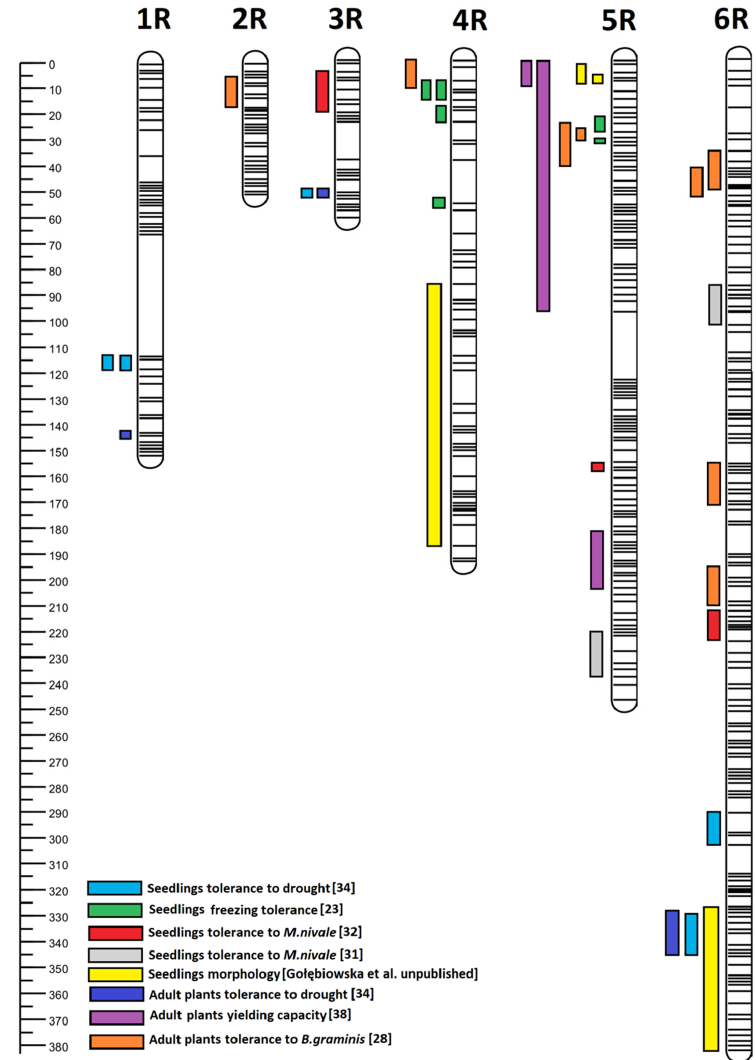
Figure 3. Subgenome R identified for the winter triticale DH ‘Hewo’ × ‘Magnat’ mapping population, related to seedlings the tolerance to drought, freezing, and pink snow mold caused by M. nivale as well as the tolerance of adult plants to drought, powdery mildew, and yielding capacity in the generative phase. Subgenome regions were determined by bioinformatics using the genetic map published by Tyrka et al. [21] and Windows QTL Cartographer V2.5_011.